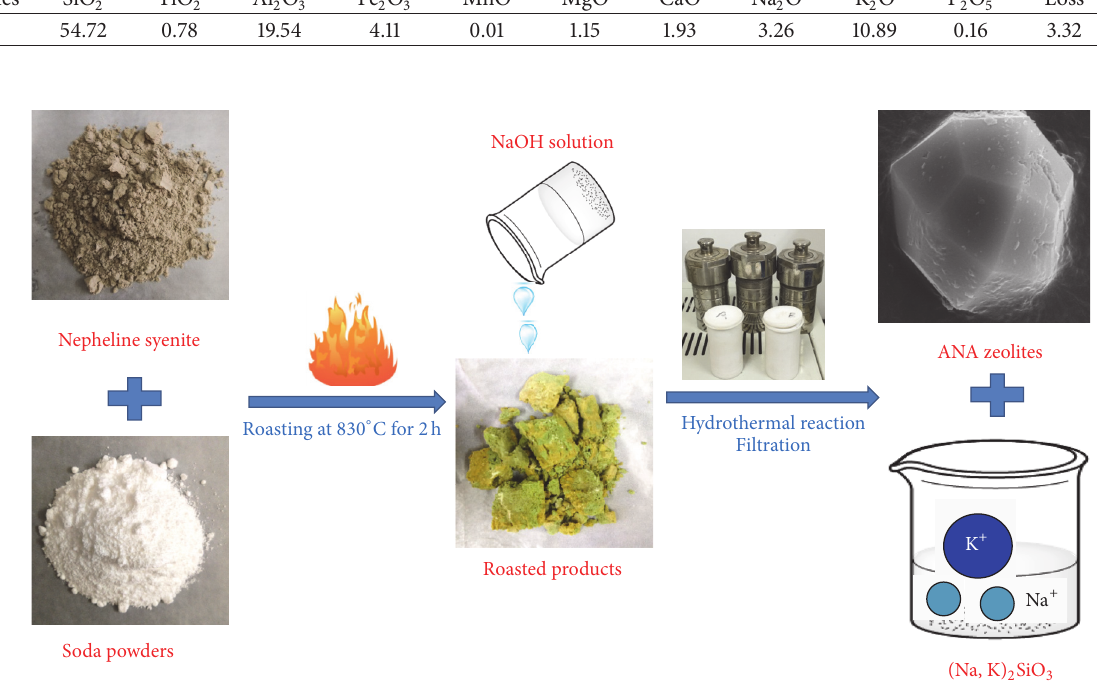
analcime synthesis with potassium extraction from natrolite syenite is shown in Figure